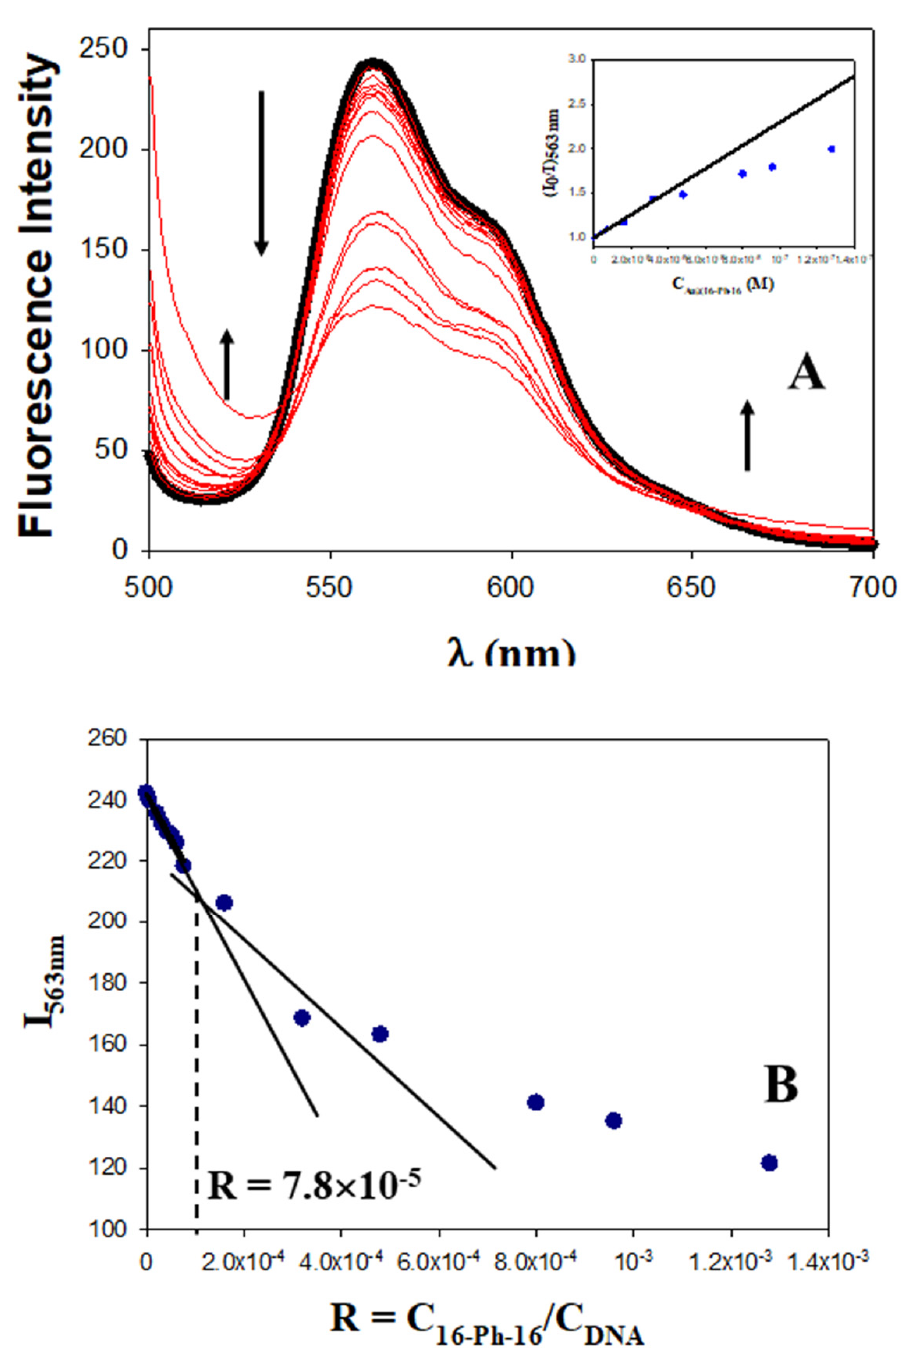
Figure 1. Fluorescence experiments with the DNA/Doxo system in the presence of different C Au@16-Ph-16 , at 298.0 K in cacodylate buffer (I = 1.63 mM, pH = 7.4); C Doxo = 2.5 µ M and C DNA = 100.0 µ M remain constant. ( A ) Fluorescence spectra of the DNA/Doxo system in the absence and presence of Au@16-Ph-16 nanoparticles. C AuNPs = 0 M (in black), C AuNPs = 0.0053–128 nM; the arrow indicates change (in blue). The inset shows the Stern–Volmer plot of the DNA/Doxo system at different C Au@16-pH-16 . Deviation from the linearity occurs at C Au@16-Ph-16 > 3.0 × 10 − 8 M. ( B ) Plot of I 563 nm versus the molar ratio, R = C Au@16-Ph-16 /C DNA .